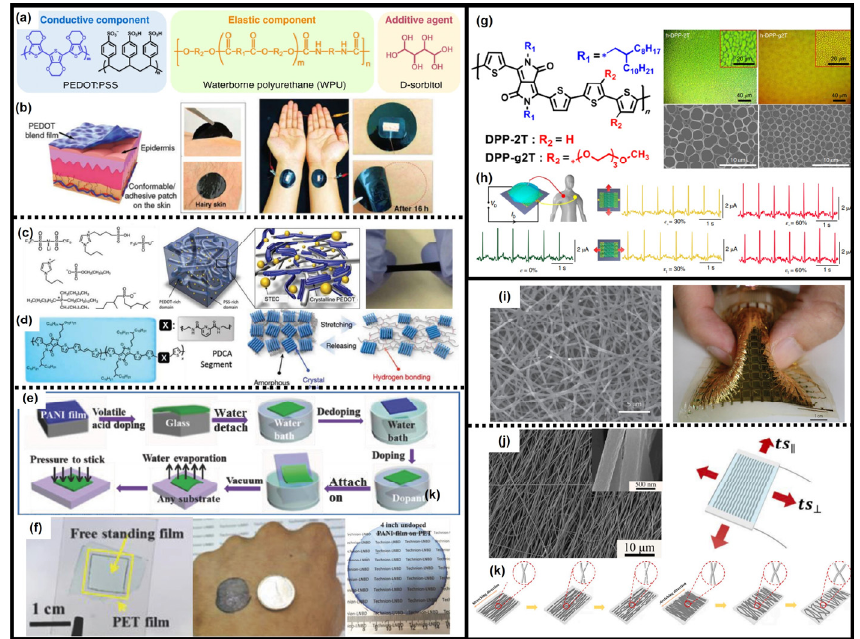
Figure 3. The conductive polymer and nanowire networks used in wearable systems. ( a ) Chemical structures of PEDOT:PSS, WPU, and D-sorbitol. ( b ) Schematic illustration and optical photo of a blend film dry electrode. Reproduced with permission from ref. [132] . Copyright 2020 Nature Pub- lishing Group. ( c ) Chemical structure of PEDOT:PSS and schematic diagram of PEDOT:PSS film with stretchability and electrical conductivity enhancers. Reproduced with permission from